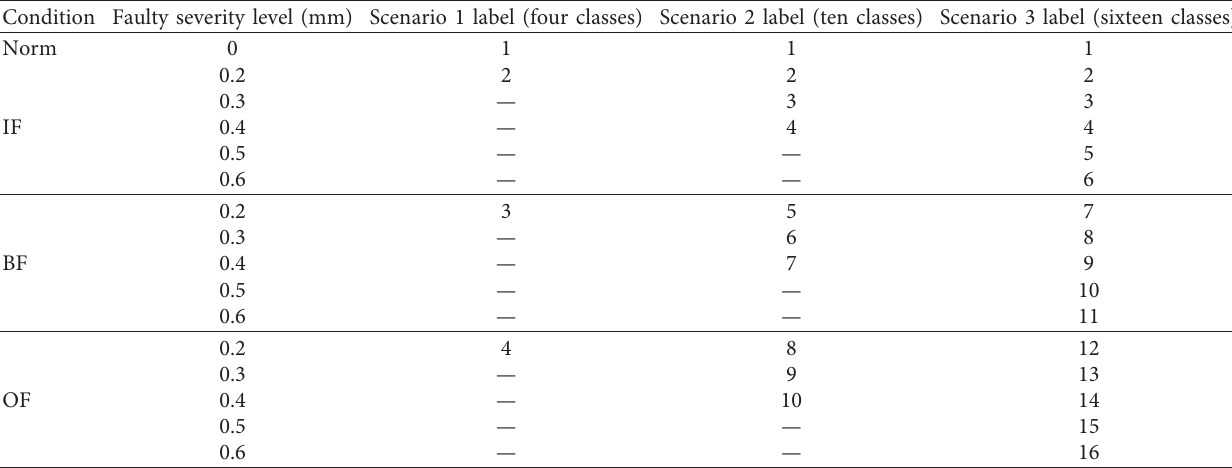
Table 3: Bearing dataset setting with three classes.